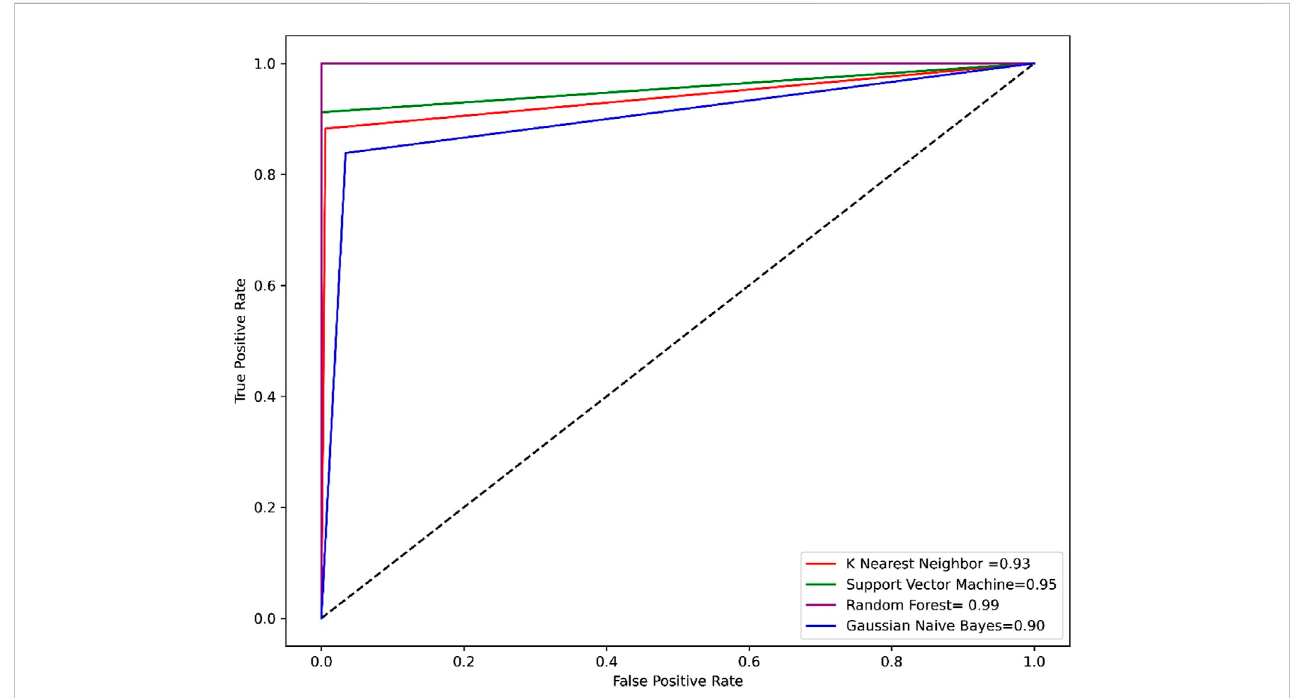
FIGURE 5 The ROC-AUC curve of all the models on the train set. The graph shows the TP against FP